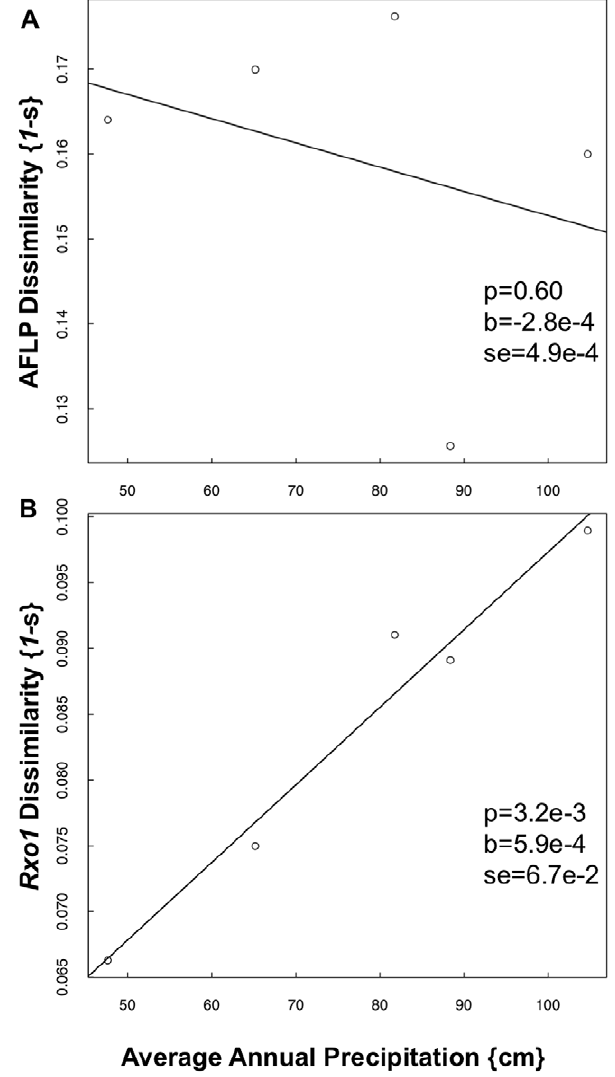
Figure 5. AFLP (a) and Rxo1 (b) dissimilarity across precipita- tion. The mean dissimilarity for each prairie was calculated and plotted according to average annual precipitation. The p-value (‘p’), slope parameter (‘b’) and standard error (‘se’) from a linear regression model are indicated.